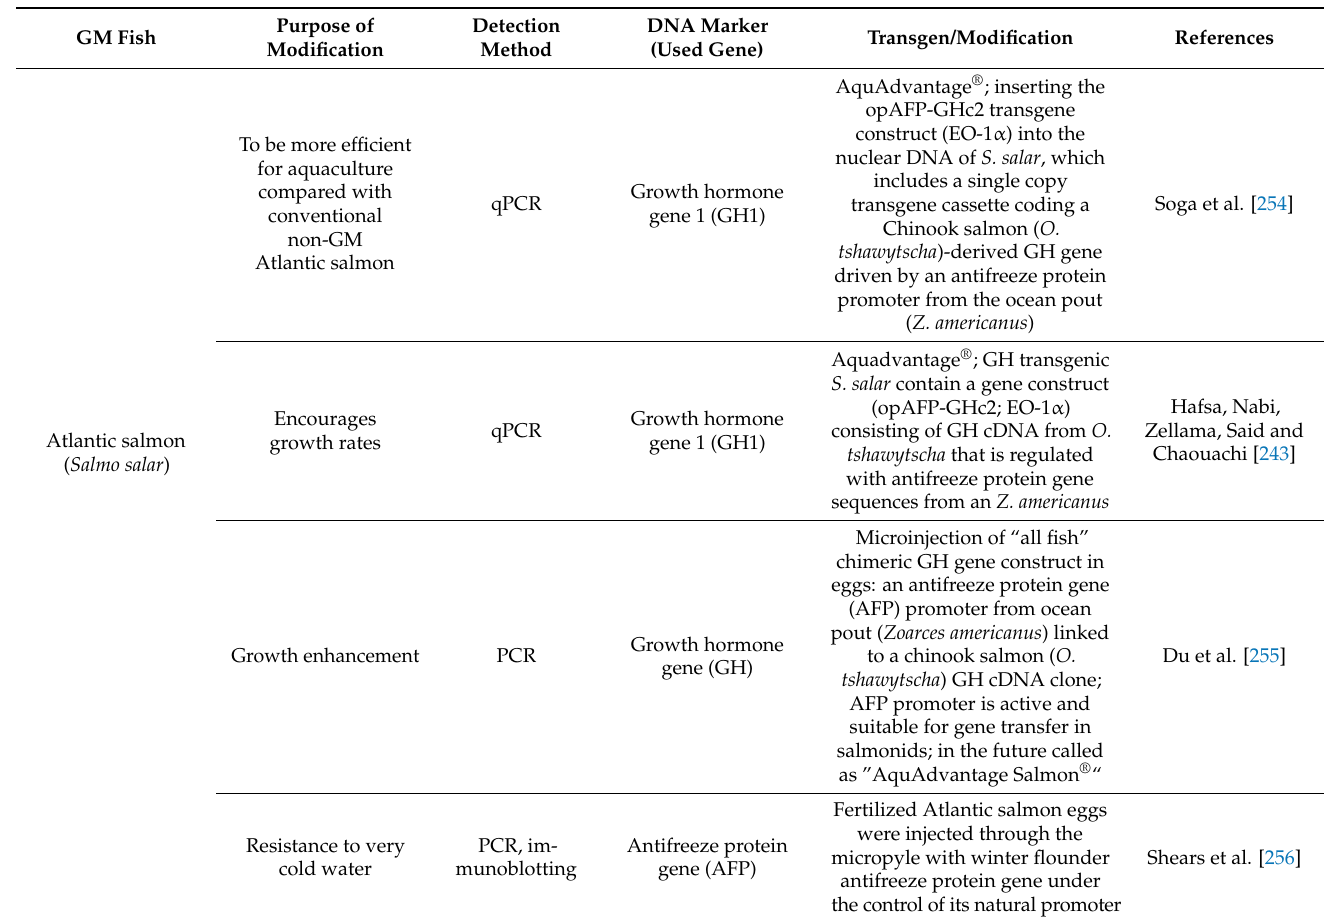
Figure 4. Major milestones in genetically modified fish research [235,247–253]. Table 3. Summary of current GM fish developed for possible commercial purposes and methods of their